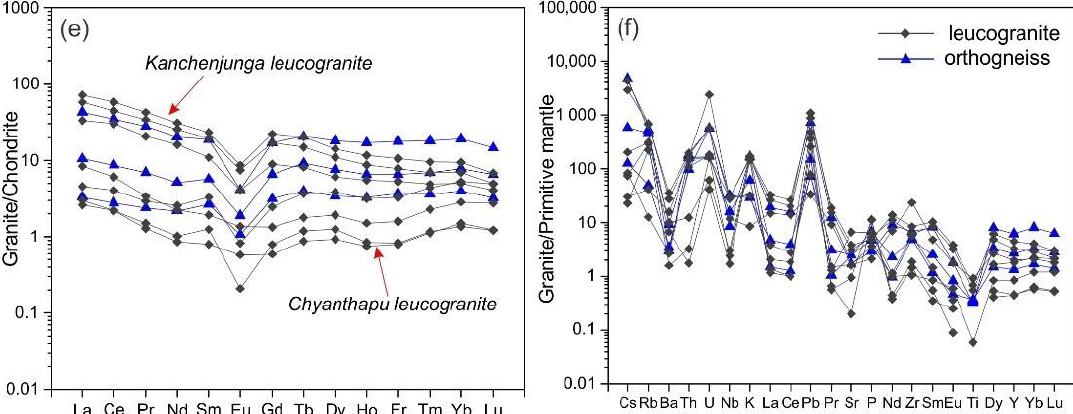
Figure 7. Chondrite-normalized REE patterns and primitive mantle-normalized multi-element patterns for ( a , b ) Be-rich pegmatite; ( c , d ) Barren pegmatites, and ( e , f ) Orthogneiss and leucogranites. Chondrite values are from [37], and primitive mantle values are from [38]. Table 2. Whole-rock major and trace element composition of selected pegmatite, gneiss and gran- ite samples.